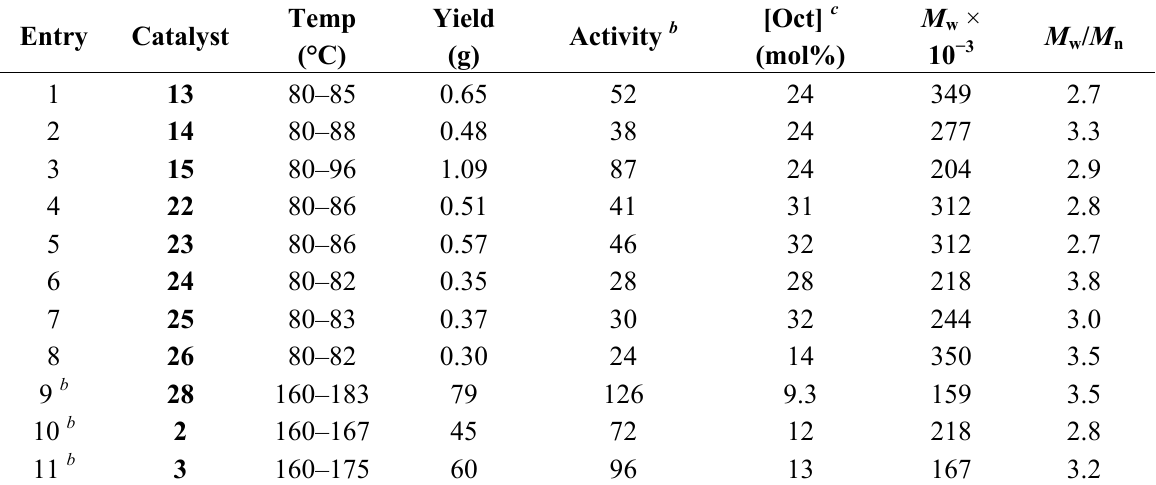
Table 2. Ethylene/1-Octene Copolymerization Results a